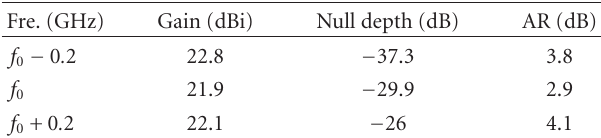
Figure 13: The gain of the high integrate broad-band microstrip antenna array using MPCB technology. Table 3: The measured data of the monopulse circular-polarized DCWS antenna